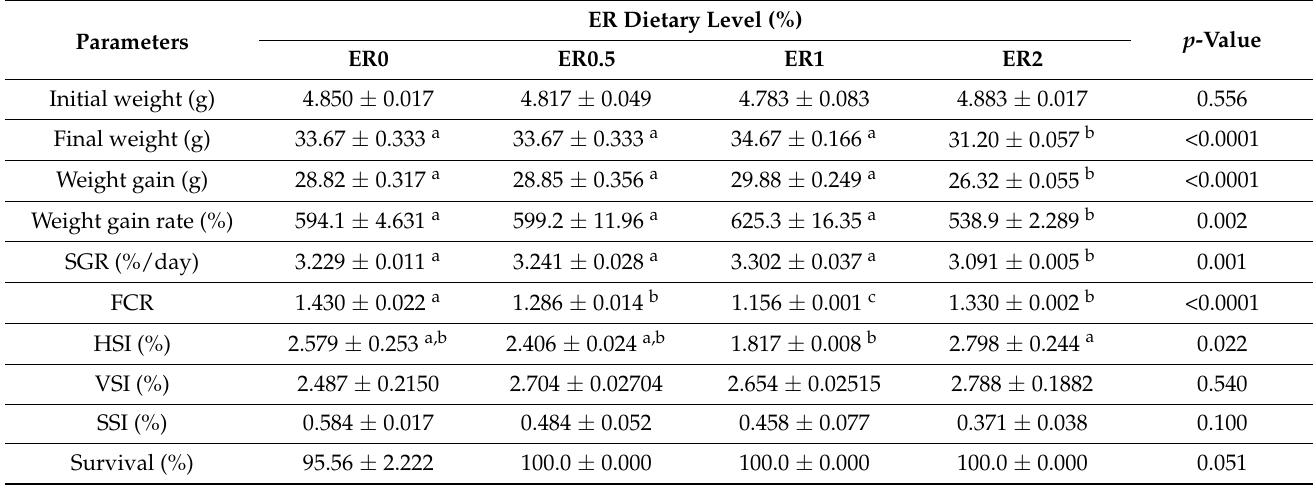
Table 4. Growth parameters and survival of Red tilapia fed various dietary levels of ER.